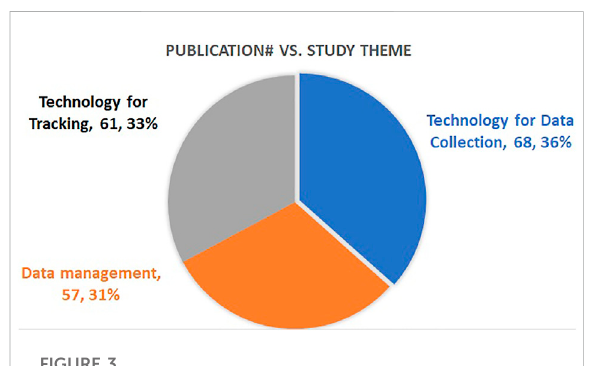
FIGURE 3 A number of publications Vs. Study Theme.